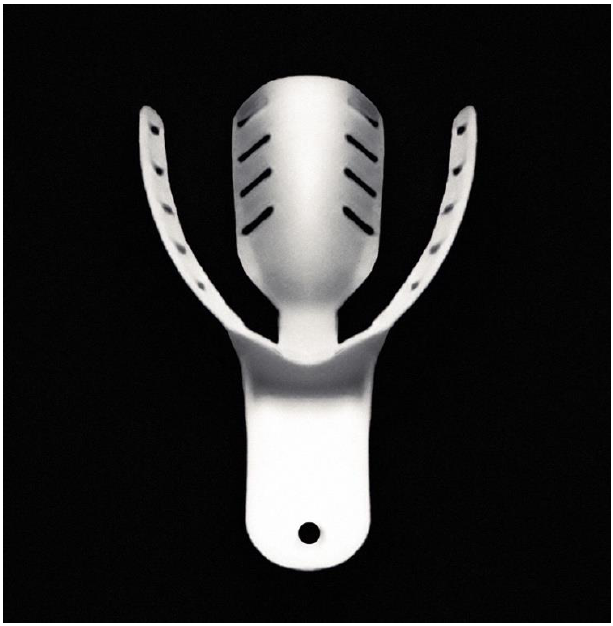
Figure 1. Customized impression tray for hybrid mouthguard fabrication.